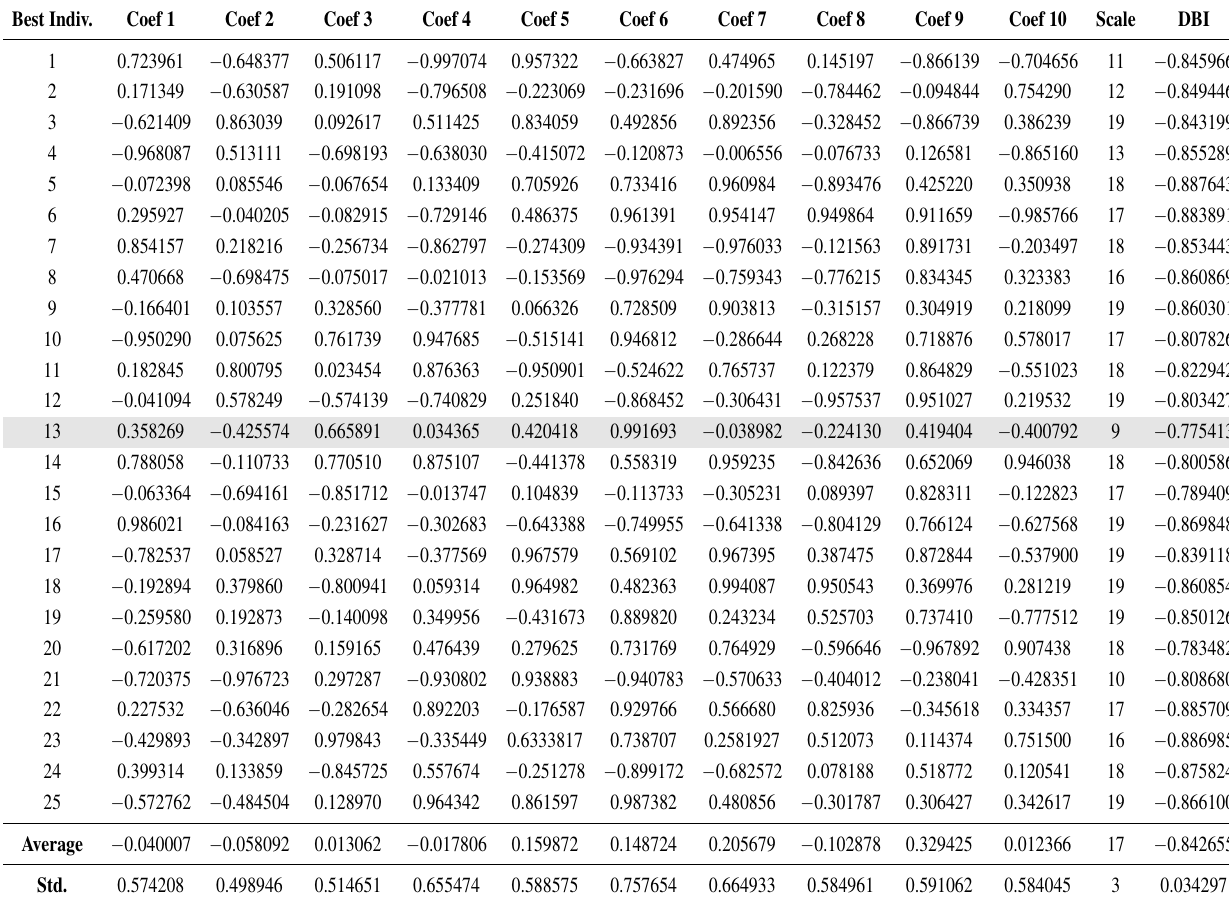
Table 2. Twenty five independent runs, showing the best individual. Coef = Coefficient. Best